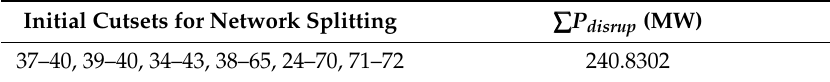
Table 4. The initial cutsets for Case